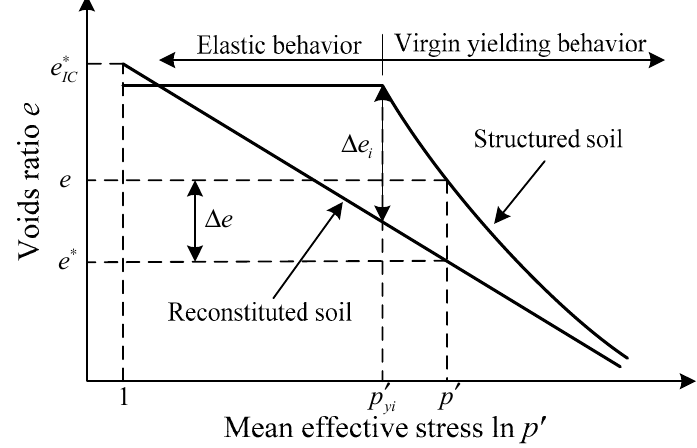
Figure 1. Conceptual model of soil responses under isotropic compression.